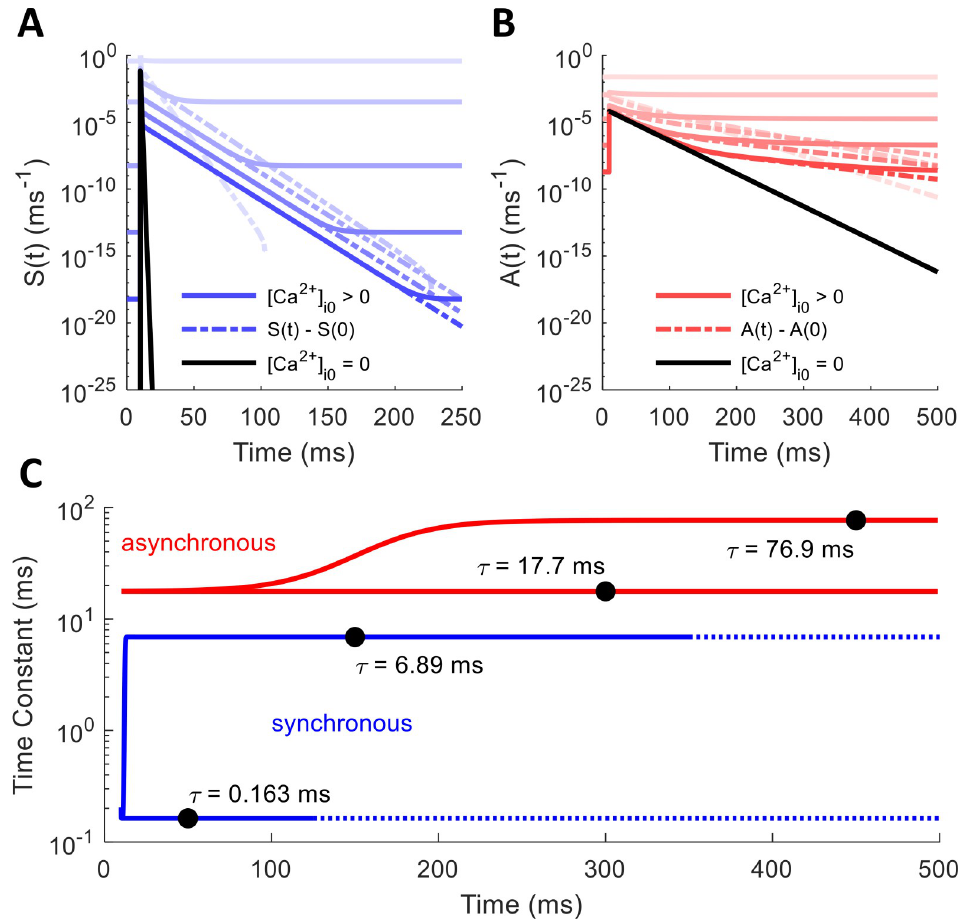
Fig 6. Synchronous and Asynchronous Release Rates in Response to Ca 2+ Impulse at Different Resting Concentrations. Instantaneous impulse of Ca 2+ delivered at 10 ms. Solid lines represent true release rate; dotted lines have spontaneous rates subtracted off to show secondary exponential components. Black lines show release rate decaying with a single exponential component with no baseline [Ca 2+ ] i . For other curves, [Ca 2+ ] i0 ranges from 0.001 μ M to 10 μ M. (A) Synchronous release rate over time: S(t). (B) Asynchronous release rate over time: A(t). (C) Instantaneous release rate decay time constants for synchronous and asynchronous mechanisms. Fast components (lower blue and red lines) determined from profiles with [Ca 2+ ] i0 = 0 (black lines in A and B). Slower components (upper blue and red curves) determined from cases with small [Ca 2+ ] i0